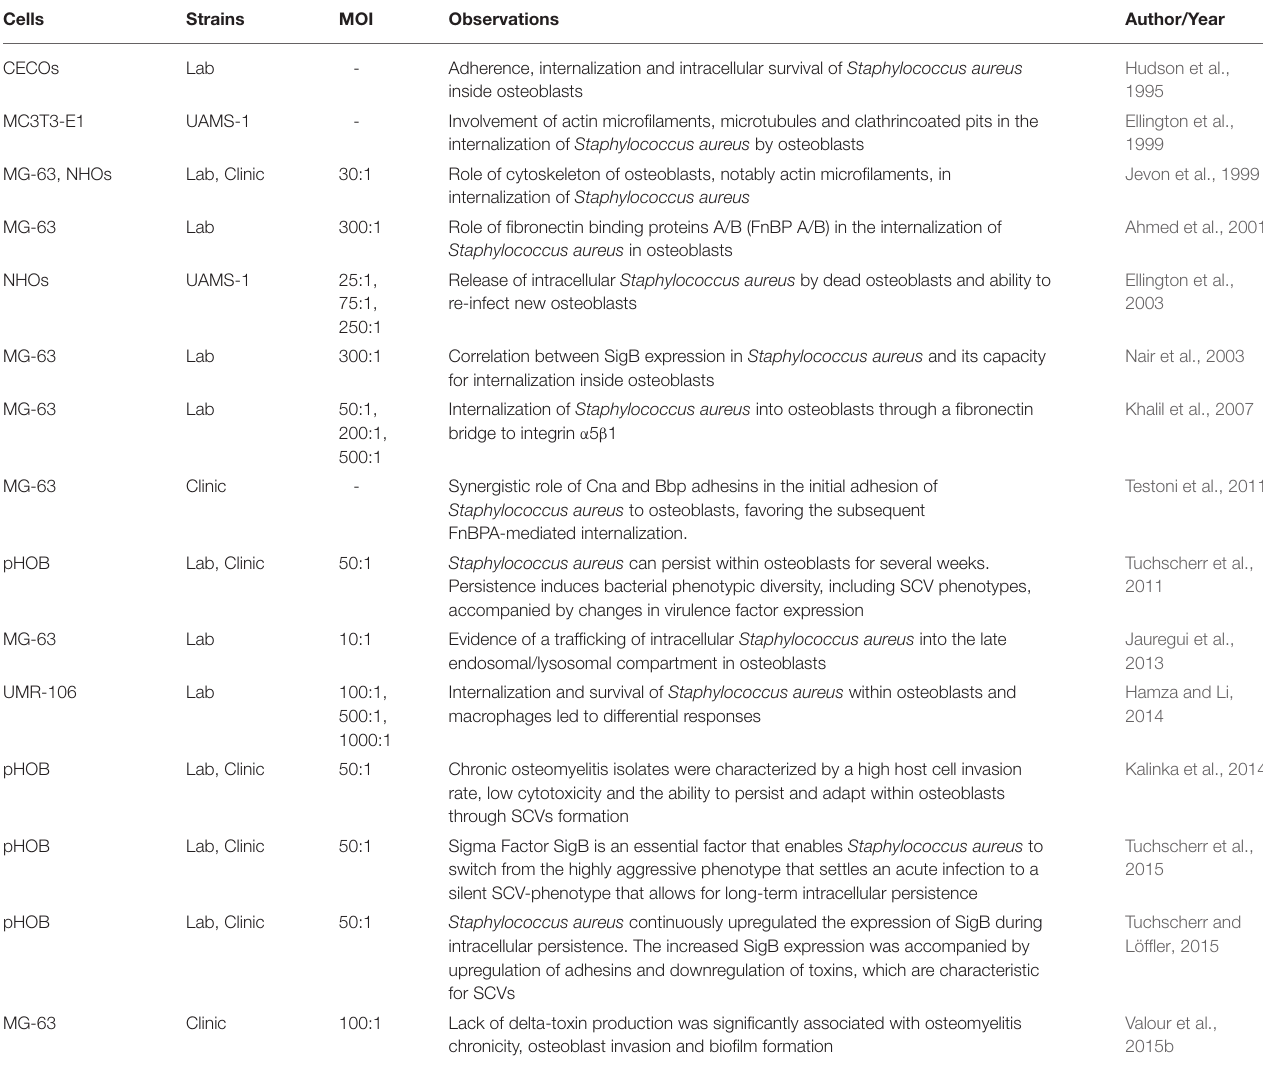
TABLE 1 | Staphylococcus aureus internalization by cultured osteoblasts. Cells Strains MOI